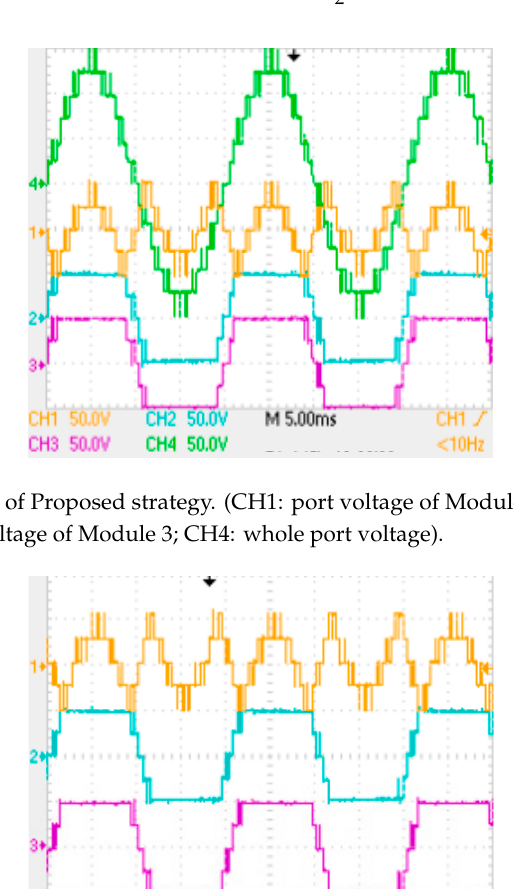
Figure 14. Switch states of PSC-SVPWM. (CH1: port voltage of Module 1; CH2: port voltage of Module